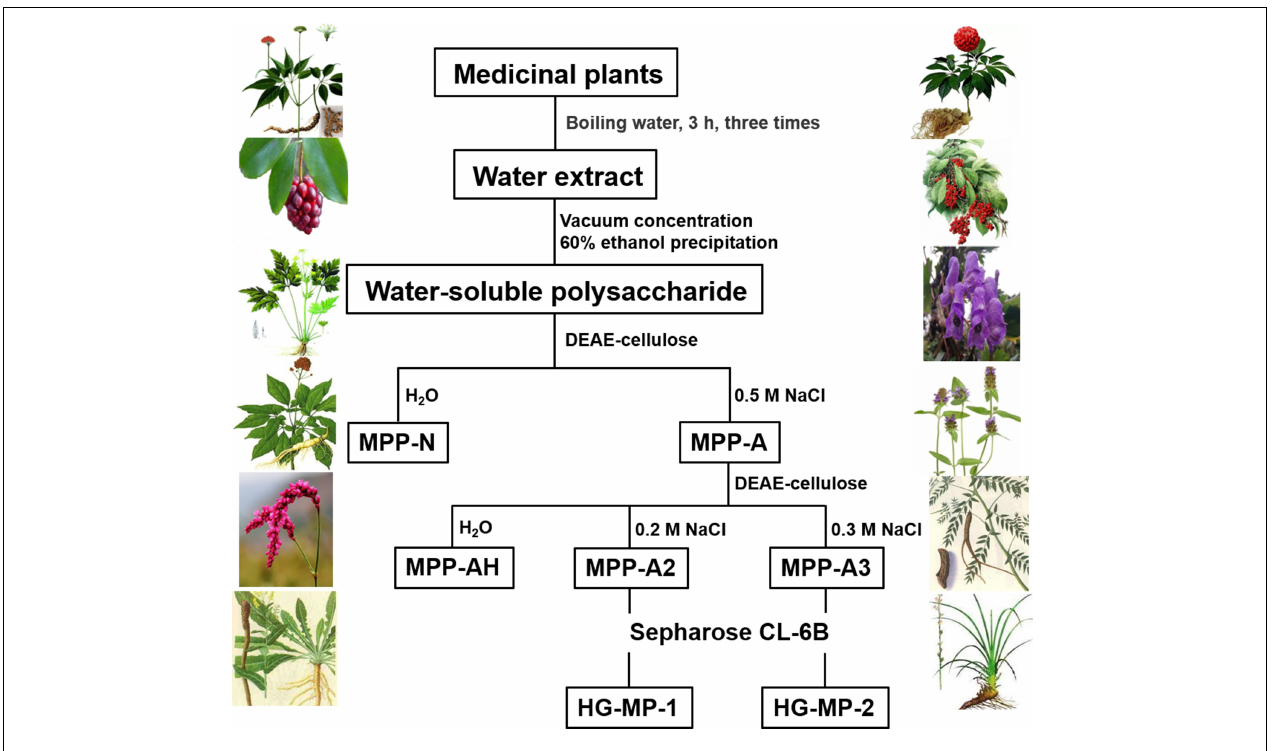
FIGURE 1 | Separation and purification of homogalacturonan (HG) pectins from plants.